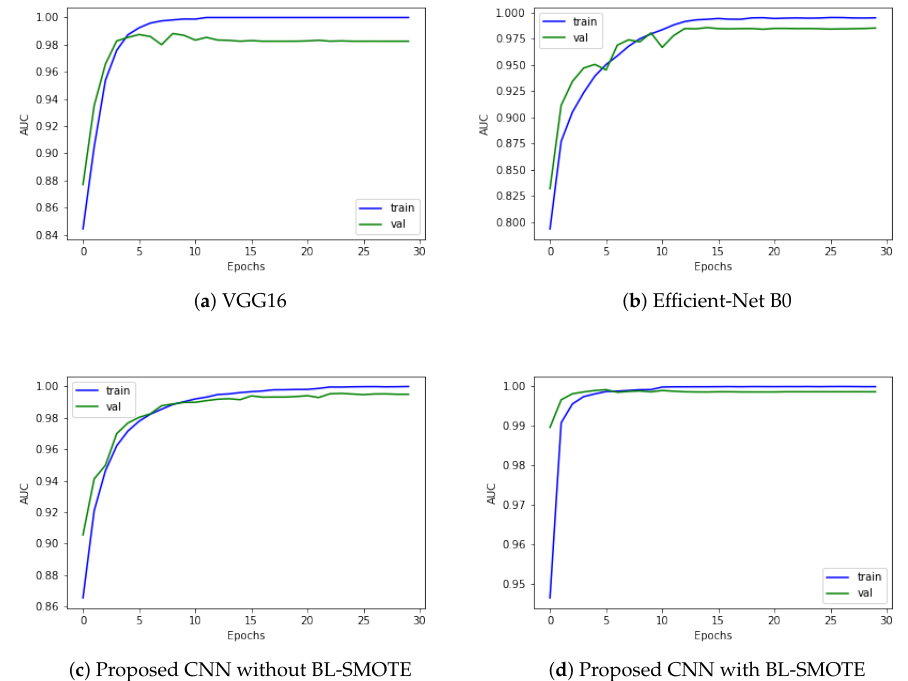
Figure 8. Area under the curve analysis to visualize multi-class classification results of ( a ) VGG16, ( b ) Efficient-Net B0, and ( c , d ) proposed deep CNN model with and without